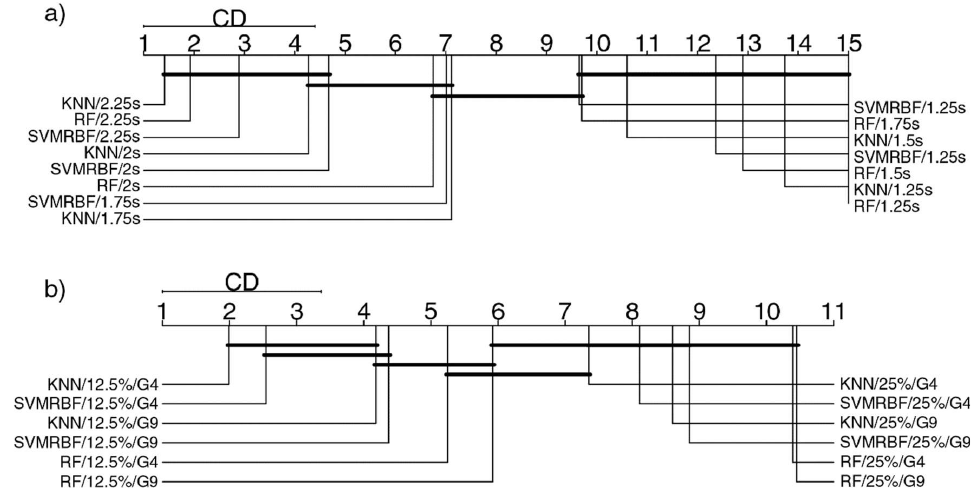
Figure 9: Critical distance diagram (CD) obtained from Friedman test and Nemenyi post-hoc test. The test was performed for ( a ) window length and ( b ) overlap rate variation. On the left, the best average rank performances are indicated. The critical di ff erence attributes are denoted by the lines that connect the distributions. They indicate where there are no statistical differences. It can be noted that a window length of 1.75 s presented similar distributions to 2.25 and 2 s in several classifiers. Even the 12.5% overlap rate showed the best ranks, and some distributions were highly related to values of 25%. Due to overlapping found in the groups of Figure 9, the distributions were analyzed separately.